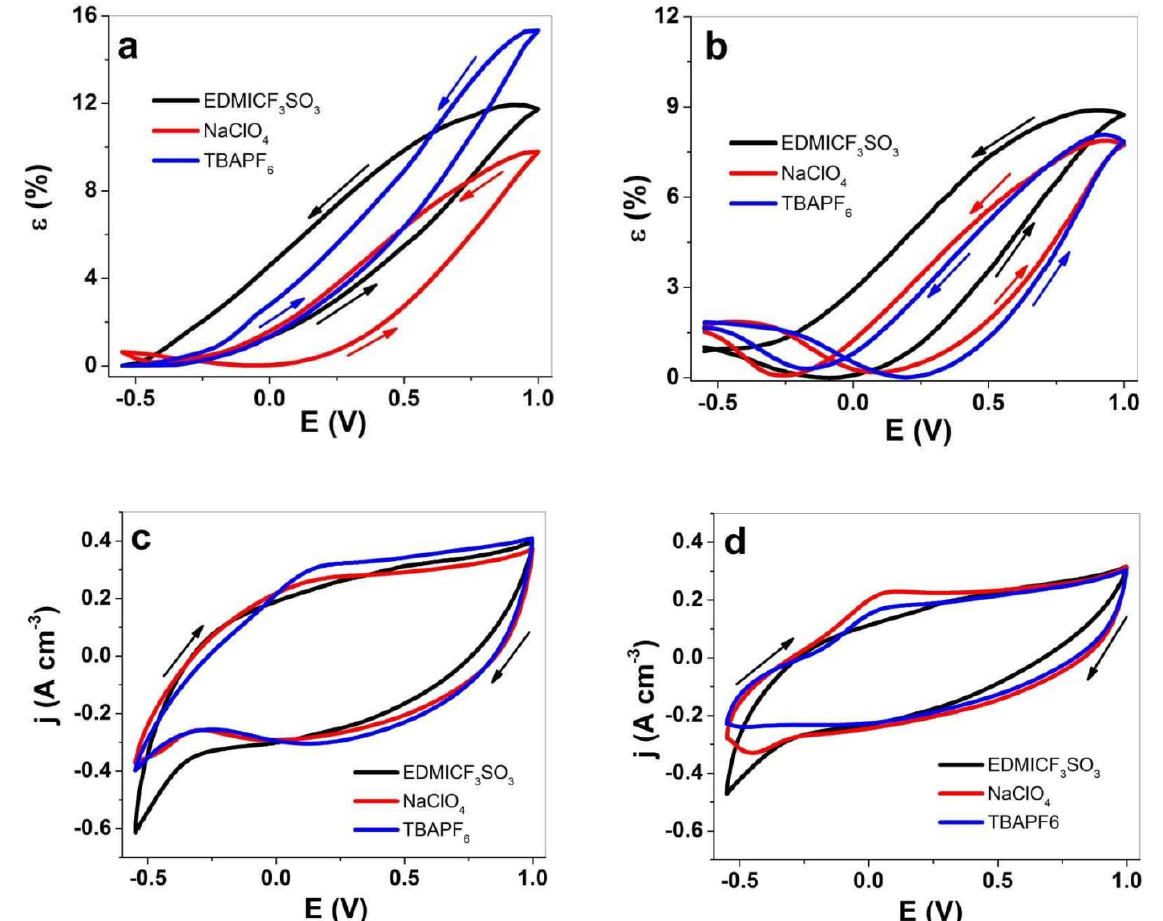
Figure 4. Cyclic voltammetry (scan rate 5 mV s − 1 ) applied to PPy samples in EDMICF 3 SO 3 -PC (black curve), NaClO 4 -PC (red curve) and TBAPF 6 -PC (blue curve) electrolytes at potential range 1.0 V to − 0.55 V showing strain ε of ( a ) PPy-PEO and ( b ) PPy/DBS against potential E. The current density potential curves for ( c ) PPy-PEO and ( d ) PPy/DBS samples. The arrows indicate the start and end points of the